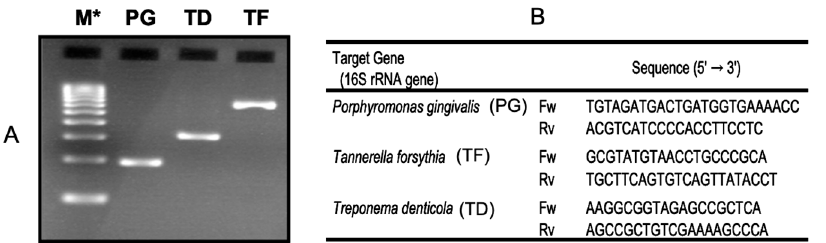
Figure 8. Detection of periodontal bacteria (PG, TF and TD) using PCR amplification [15] ( A ): Elec- trophoretic pattern of amplified PCR products. M* molecular size marker; ( B ): Sequence of PCR primers for periodontal bacteria.